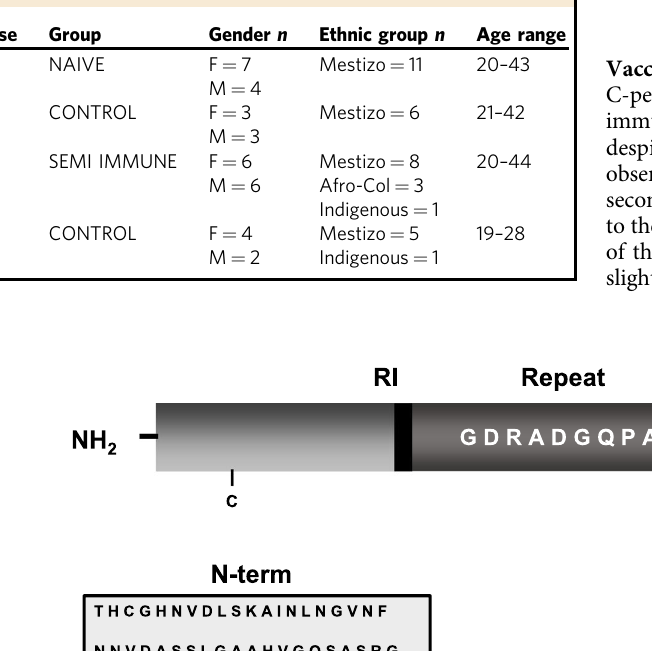
Table 1 Baseline characteristics of the vaccine groups and volunteers.